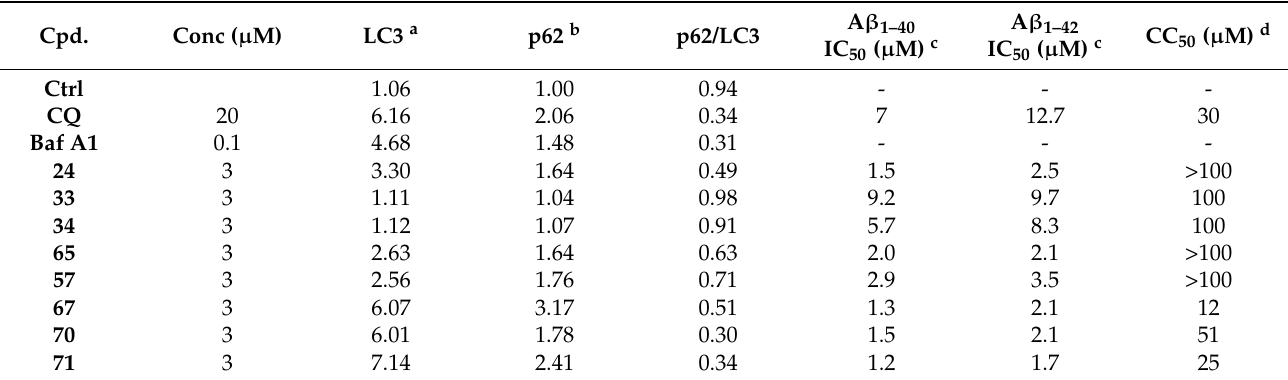
Table 3. The LC3, p62, and p62/LC3 ratio comparison with the cytotoxicity of compounds 24 , 33 , 34 , 57 , 65 , 67 , 70 , and 71